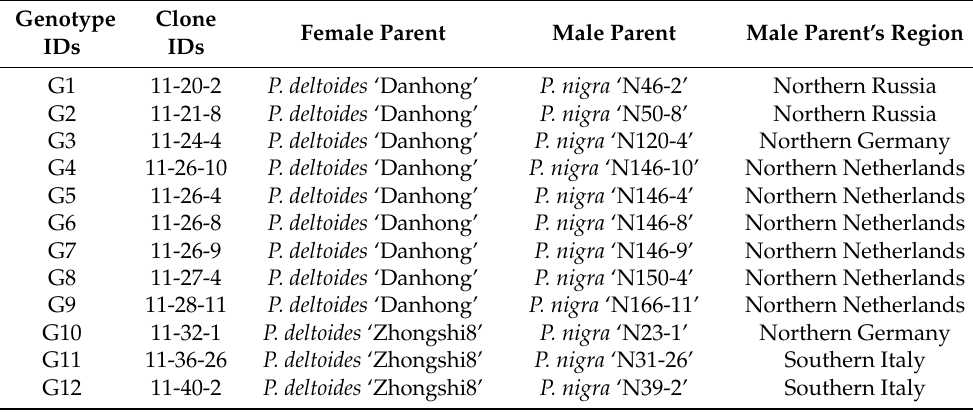
Table 2. Description of Populus Euramericana used in MET. The female parent of genotypes 1 to 9 is the Chinese poplar cultivar “Danhong”, and the remainder are Chinese poplar cultivar